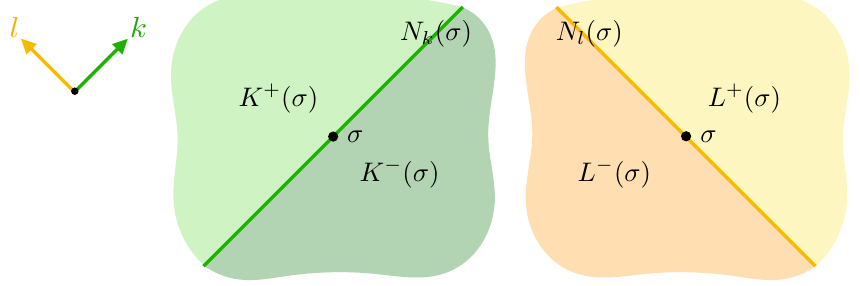
(cid:6) ( (cid:27) ) and L (cid:6) ( (cid:27) ) de(cid:12)ned in eq. (2.4),